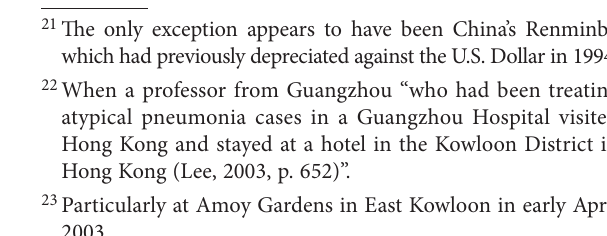
Dummy variable 2: SARS